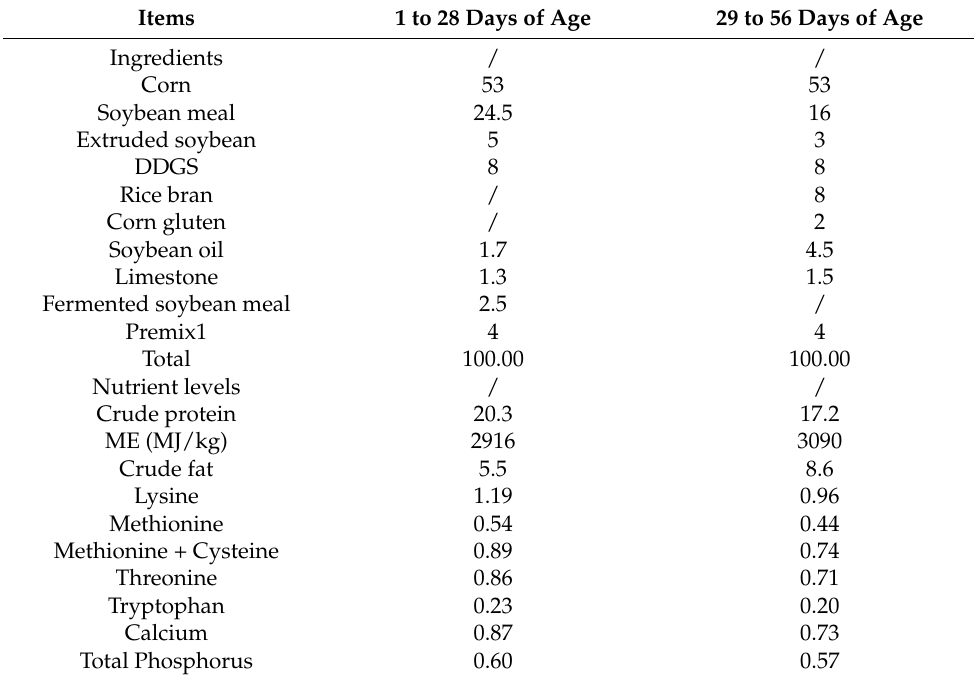
Table 2. Composition and nutrition levels of basal diet.